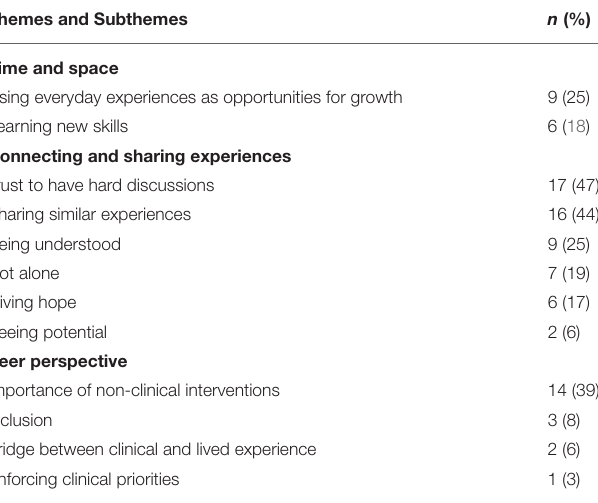
TABLE 1 | Frequency of themes and subthemes identified. Themes and